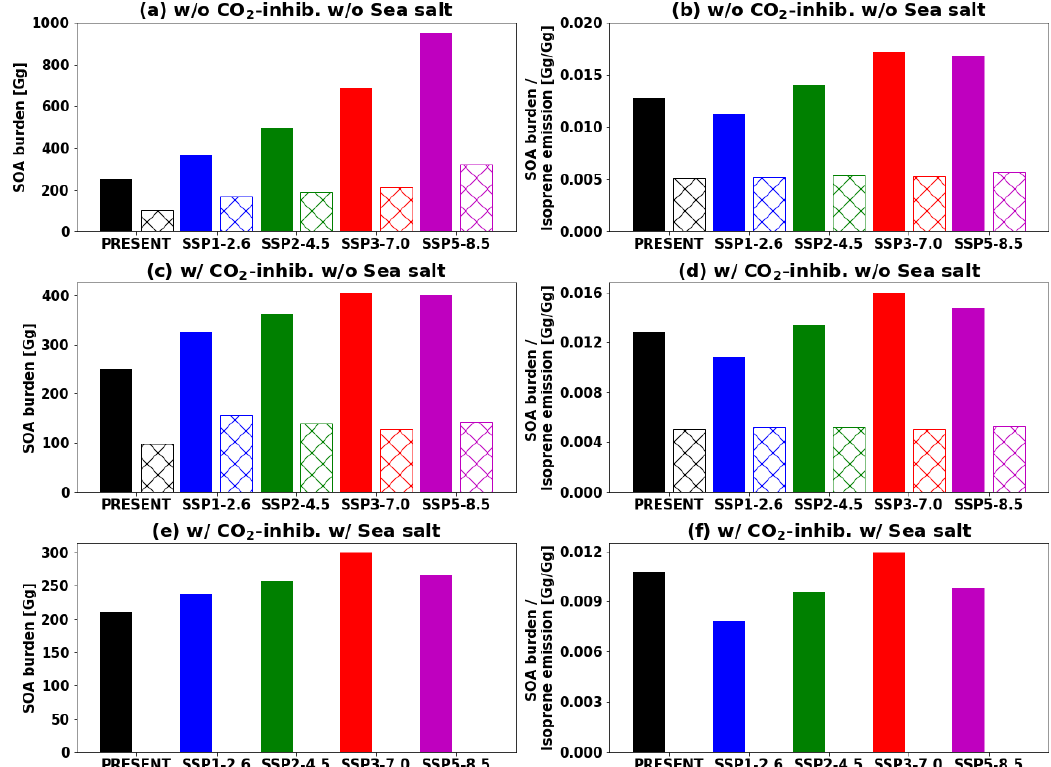
Figure 13. Global tropospheric SOA burden (a, c, e) and SOA burden divided by annual isoprene emissions (b, d, f) . IEPOX SOA simulated by the explicit chemistry and isoprene SOA simulated by the VBS are shown as filled and hatched bars, respectively. Values in the future are for the 2090s. (a–b) EXP and VBS. (c–d) EXP_CO2 and VBS_CO2. (e–f) EXP_ SS_CO2. The VBS SOA is not included in (e–f) as we did not have a simulation for the corresponding case (sea salt included in aerosol pH calculation and CO 2 inhibition effect considered).